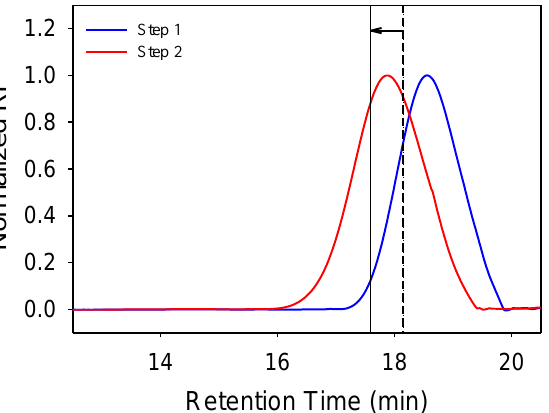
Figure 7. GPC curves of PCL collected during 2-step monomer addition. Conditions: DMC-EAA = 10 mg ([ Zn ] 0 = 30 mM), [ CL ] 0 = 9 M, [ CL ] 0 /[ SB ] 0 = 10, T p = 160 °C.